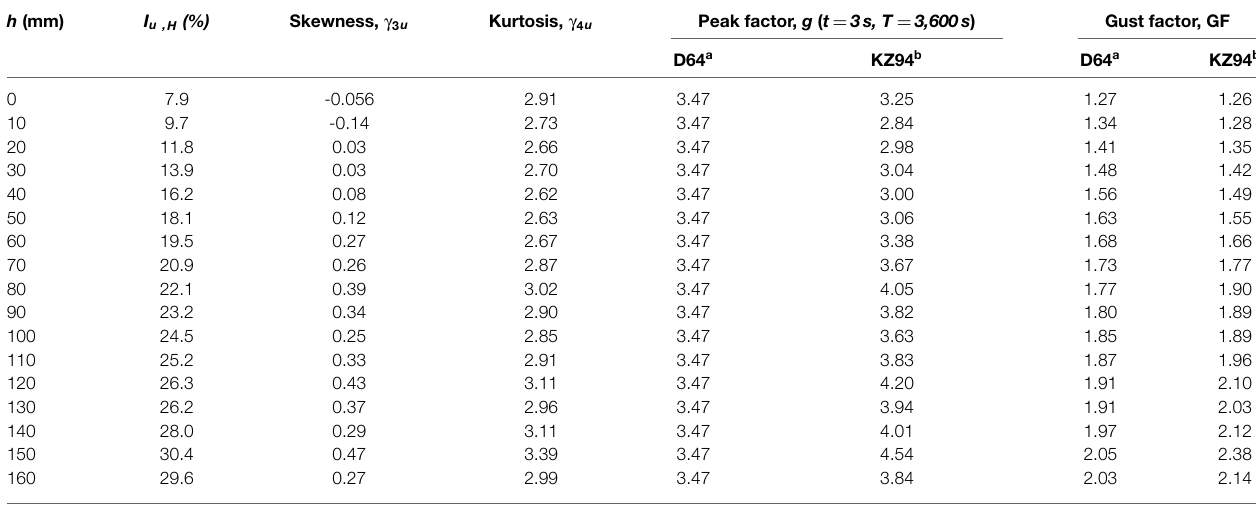
TABLE 4 | Gust factor estimates based on turbulence levels at eave height (wide edge).